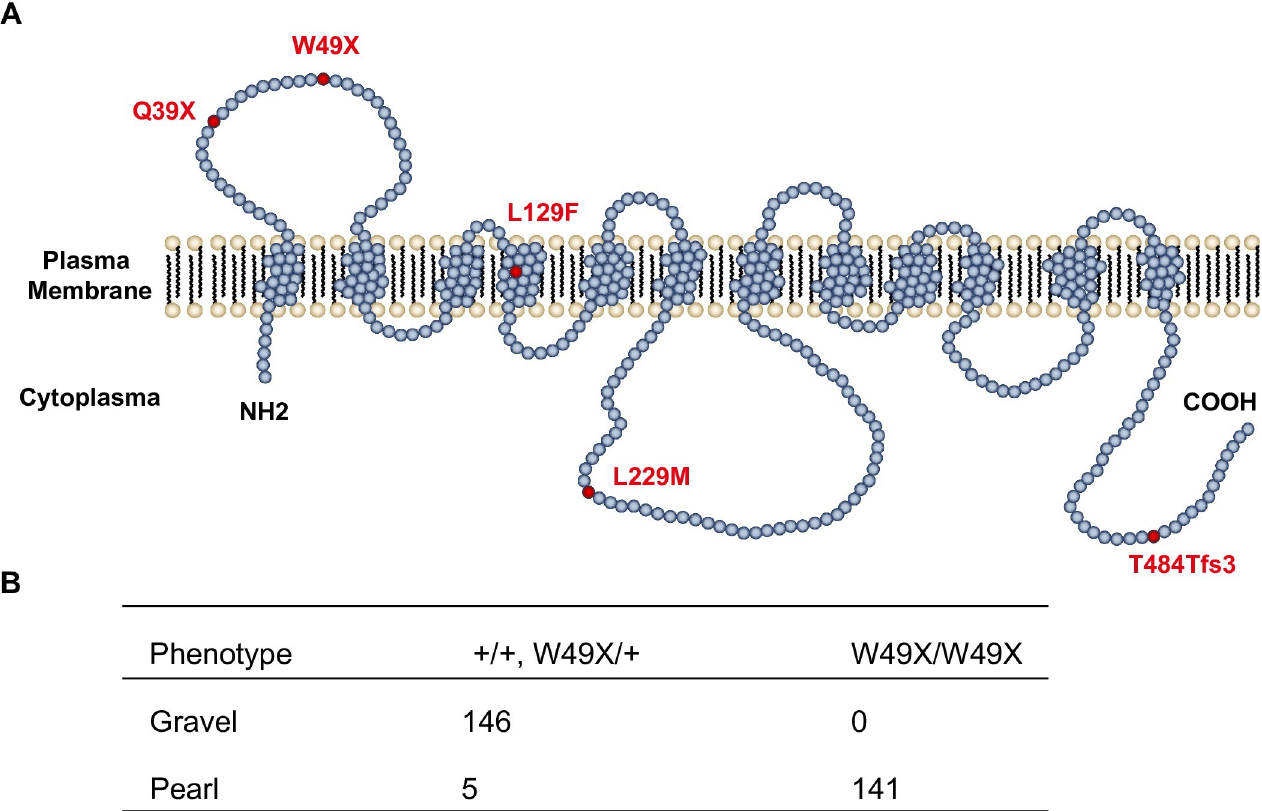
Fig 3. SLC2A11B mutations in avian species. (A) Schematic diagram of the SLC2A11B protein with 12 transmembrane domains. The SLC2A11B mutations in birds are highlighted in red. (B) Validation of the SLC2A11B W49X mutation in domestic pigeons.